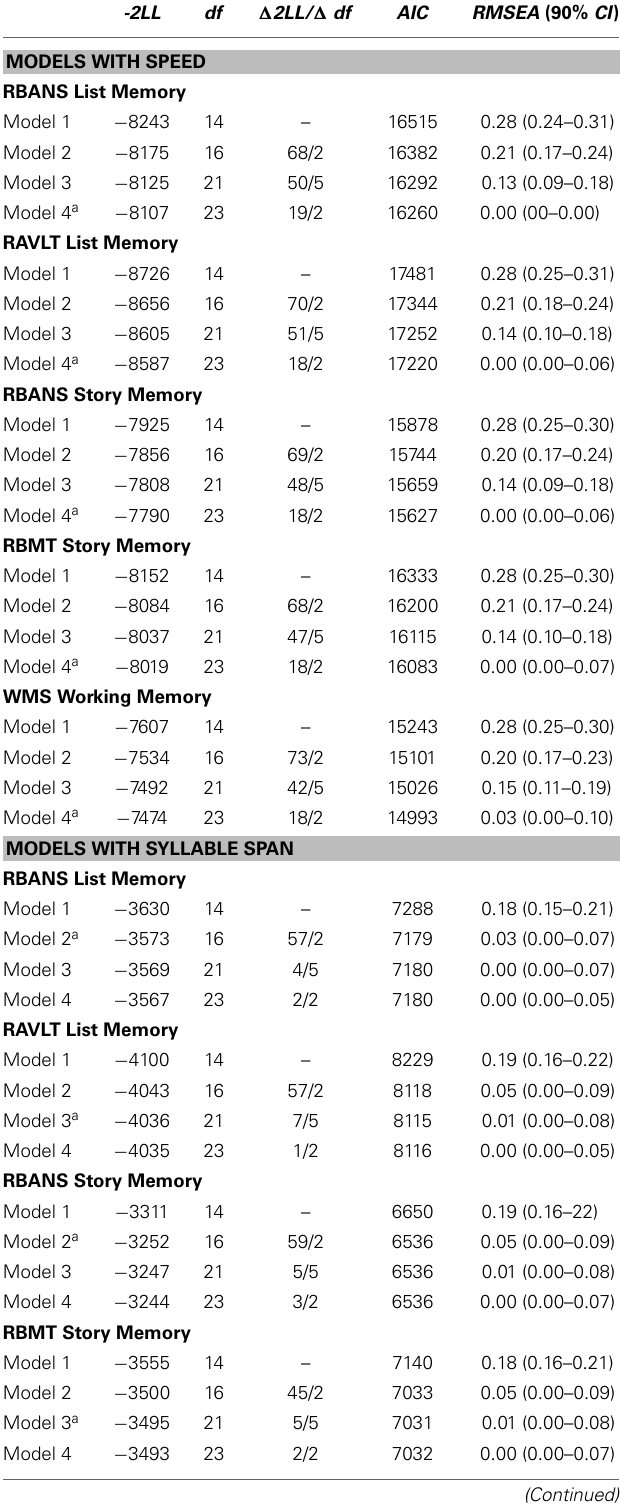
Table 5 | Nested tests of fit for models with speed (top panel) or syllable span (bottom panel) and each of the outcome factor scores testing parameter differences between experimental and active control